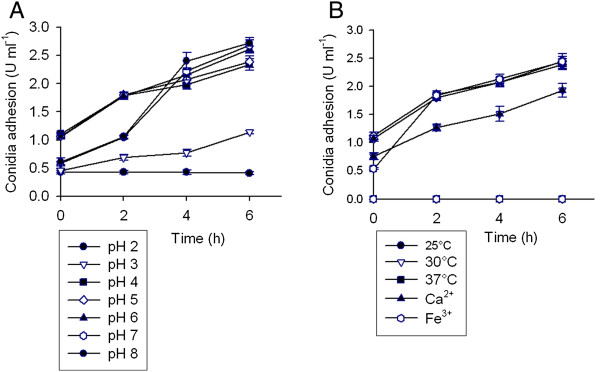
Time course of A. niger MYA 135 conidia adhesion observed in basic medium (BM) at different initial pH (A), temperature of incubation and in the presence of either 0.5 g l-1 CaCl2 or 1 g l-1 FeCl3 (B). Error bars represent the standard deviation calculated from at least three independent experiments.